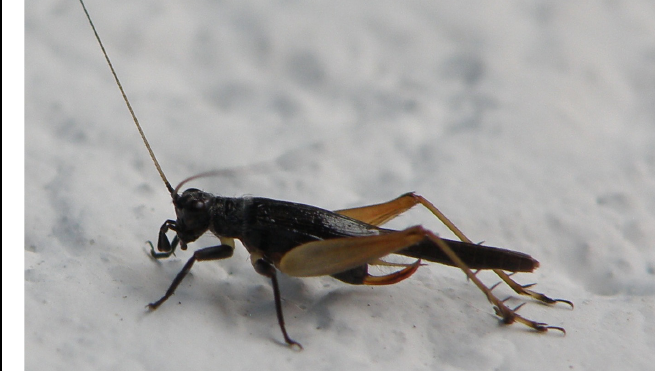
Figure 11. Trigonidium cicindeloides , female, Macedonia, Chalkidiki, Afitos, 11 VII 2016.